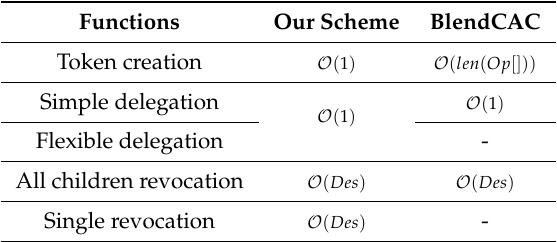
Table 11. The gas used in